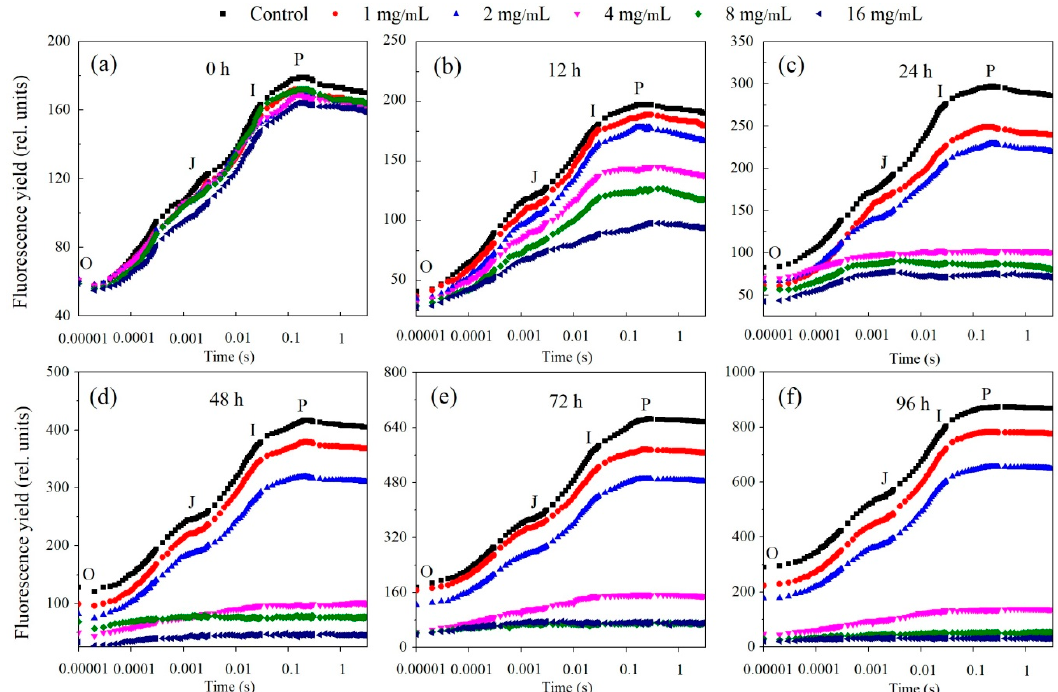
Figure 2. The chlorophyll-a fluorescence transient induction curves of P. globosa marked with OJIP phase (O: initial fluorescence value, J: fluorescence value in 2 ms, I: fluorescence value in 30 ms, P: maximum fluorescence value) at 0, 12, 24, 48, 72 and 96 h, respectively ( a – f ). The data are presented as mean values ( n = 4).